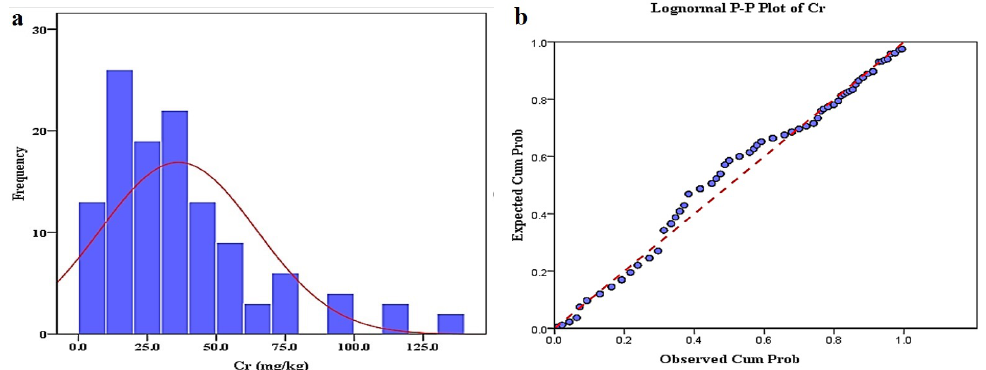
Figure 4. Histogram ( a ) and P-P plot ( b ) of Cr concentration in soil